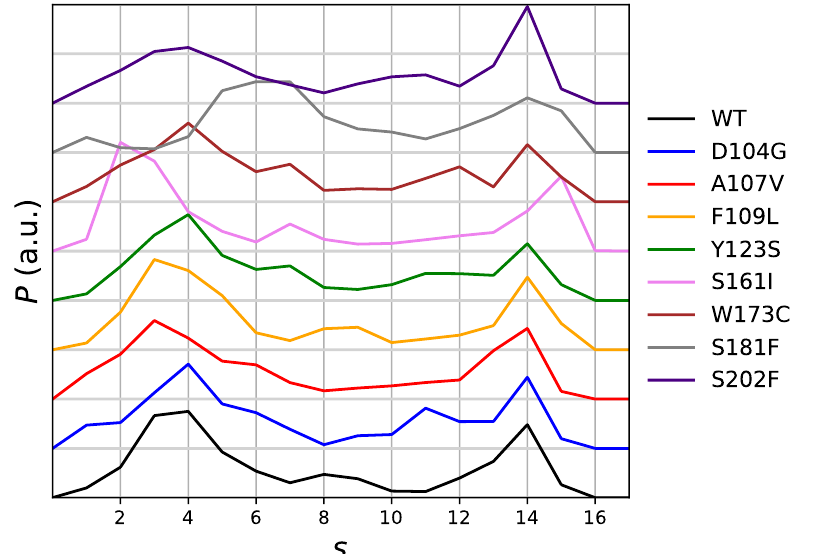
Figure 2. Distribution of collective variable in the meta-statistics (Equation (2)). Variants are ordered according to increasing mutated residue number. From bottom to top: WT, D104G, A107V, F109L, Y123S, S161I, W173C, S181F,